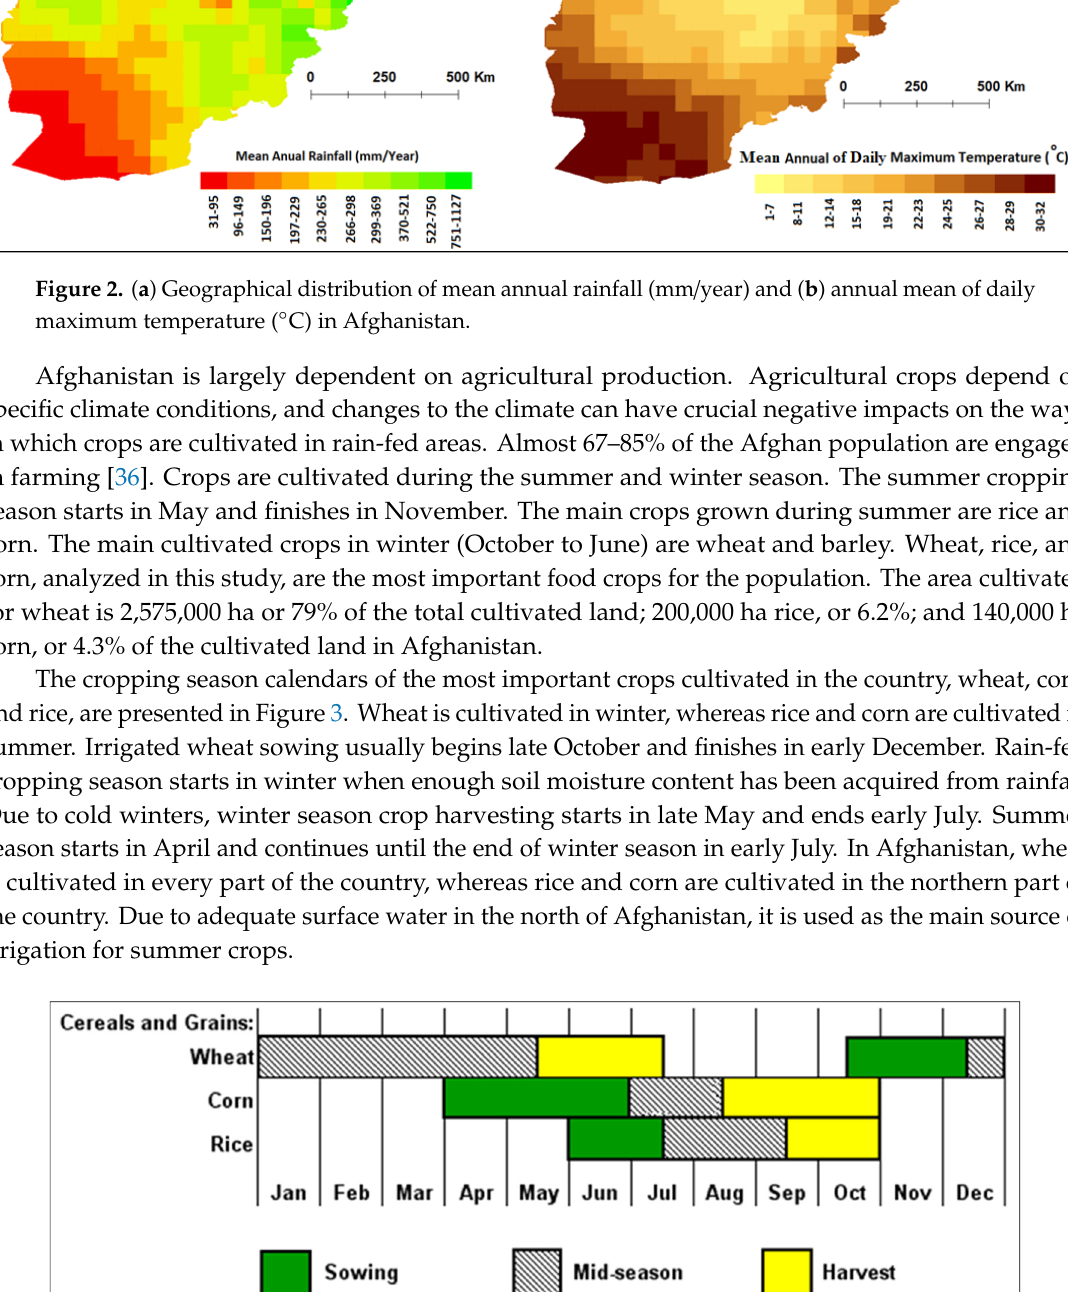
Figure 1. Map of Afghanistan showing elevation and country borders.